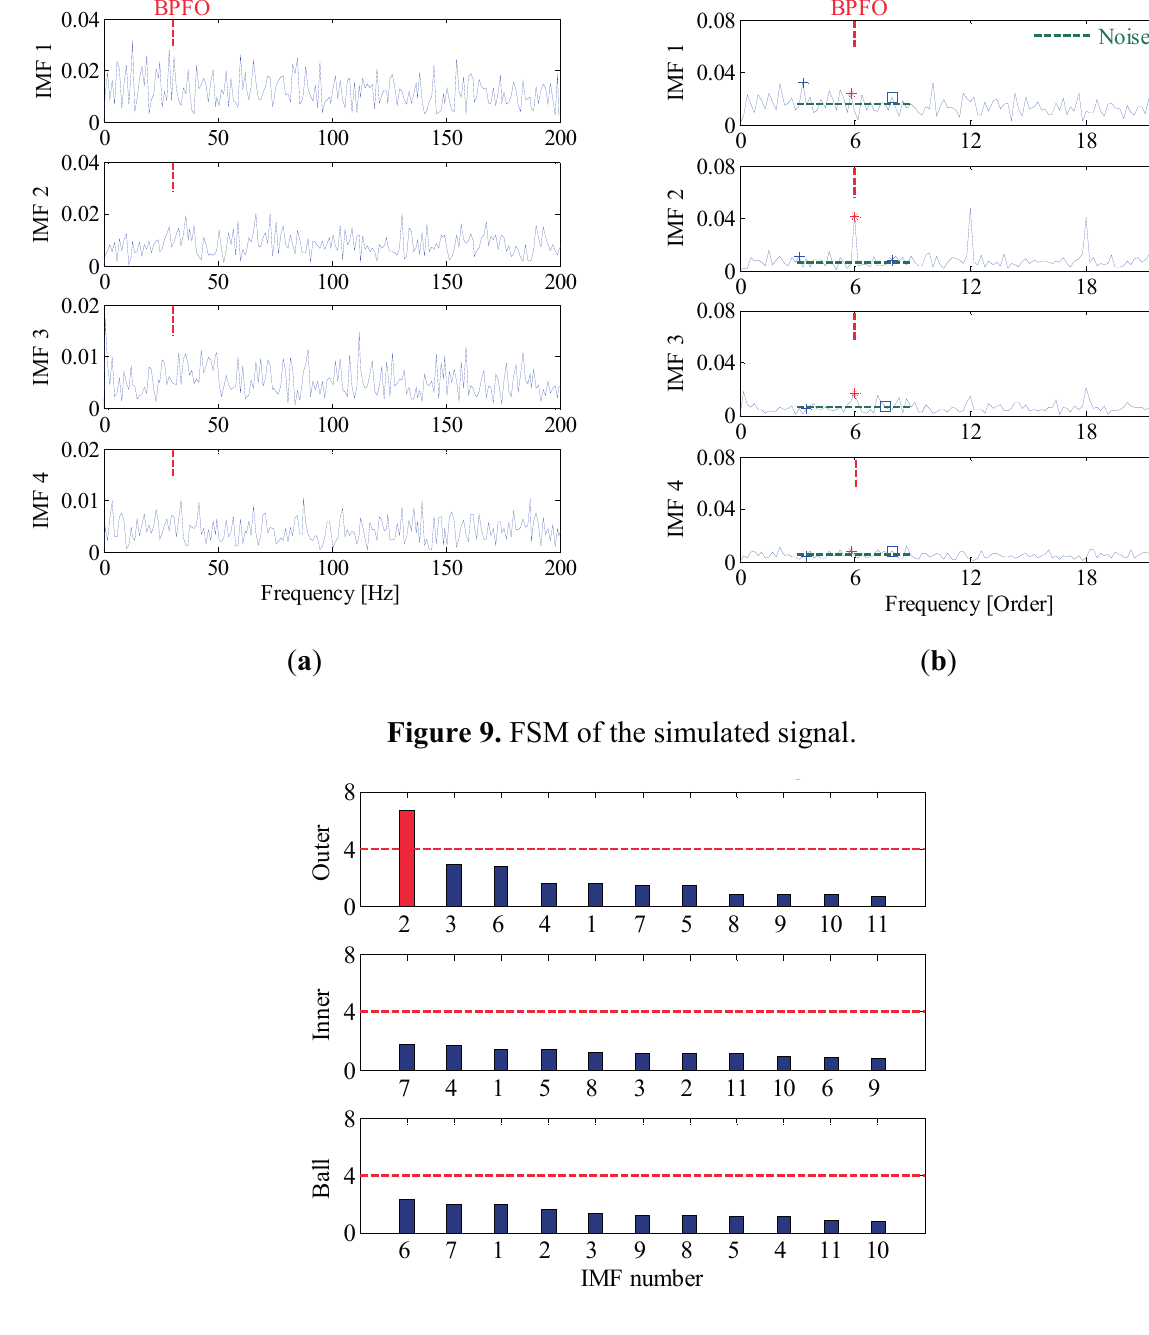
Figure 9. FSM of the simulated